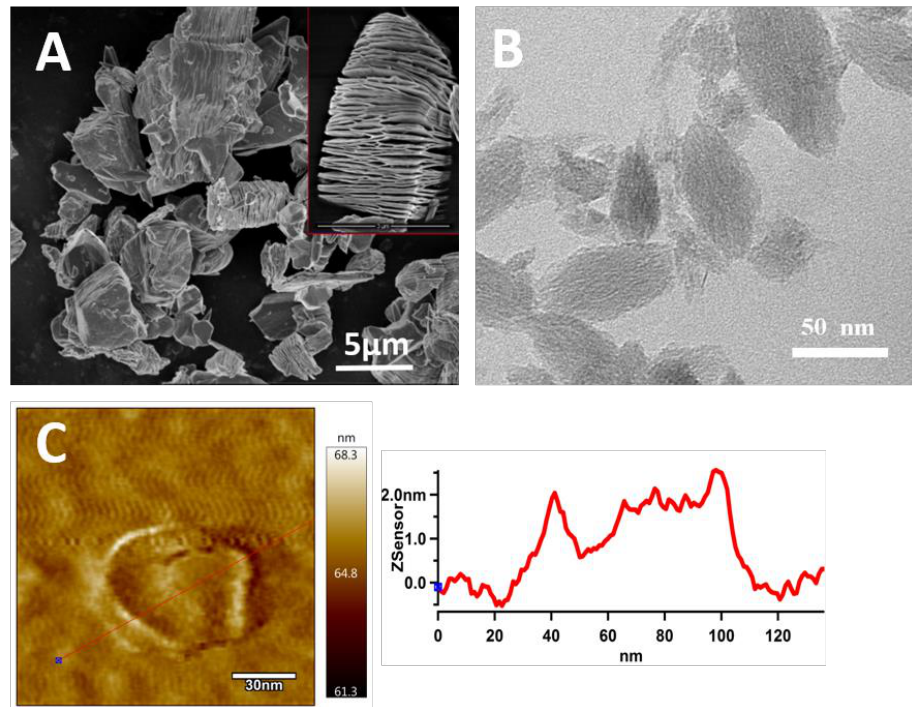
Figure 1. ( A ) SEM of MAX phase and ( B ) TEM image and ( C ) atomic force microscopy (AFM) image with line profile of MXene particles.